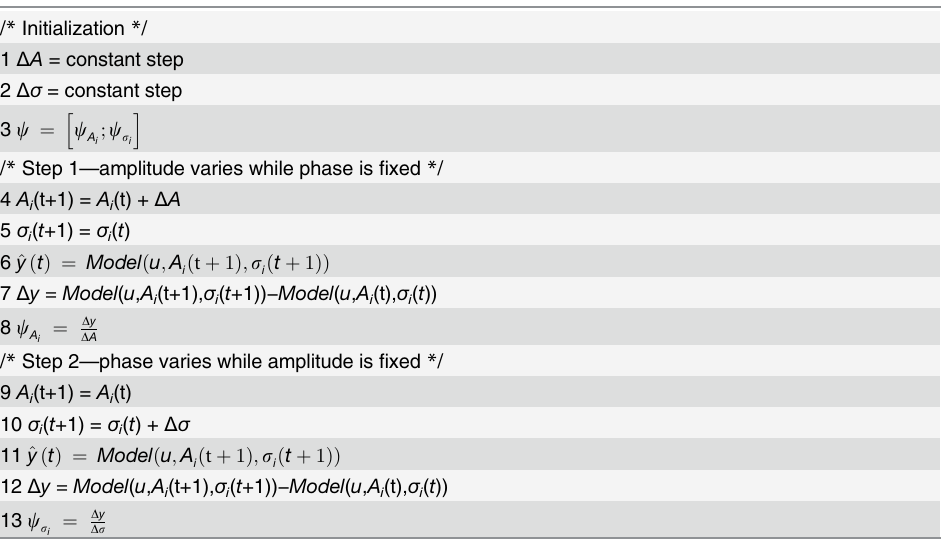
Table 1. Gradient algorithm.